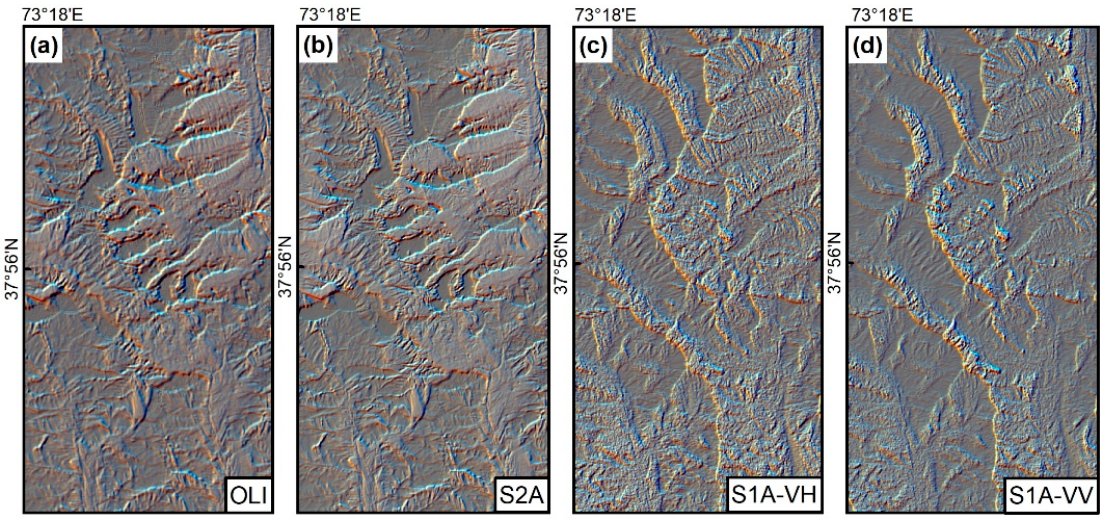
Figure 4. The RGB composite images of three optimal filtered directions (0, 45, and 90) from ( a ) OLI band-6, ( b ) S2A band-11, and ( c , d ) S1A VH and VV polarizations, respectively.